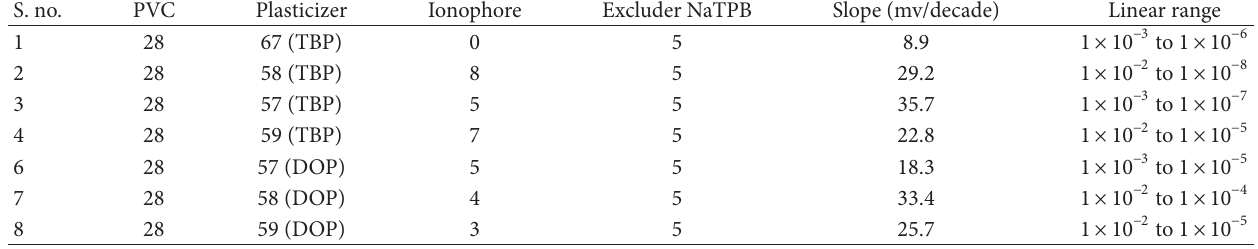
selective sensors based on them. 2+